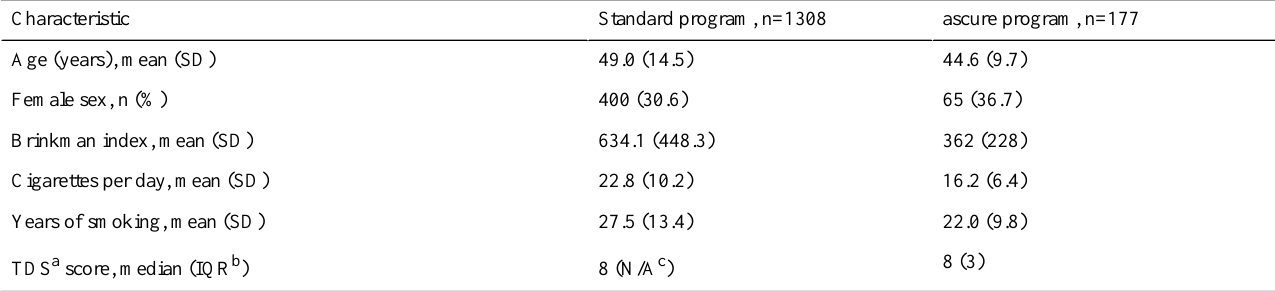
Table 4. Baseline characteristics of the participants.